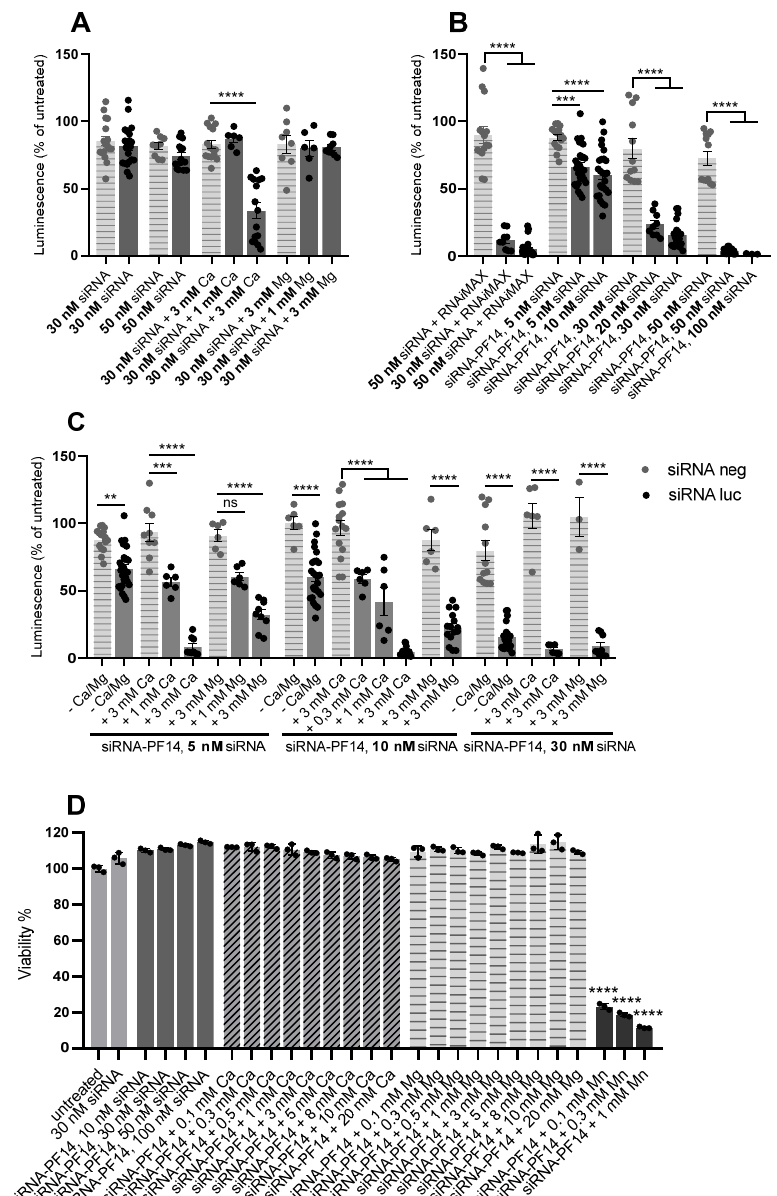
Figure 9. Effect of calcium and magnesium ions on siRNA-induced gene silencing and viability of U87 cells. U87-luc2 cells were incubated with nanoparticles of 5 to 100 nM siRNA, PF14 or Lipofectamine RNAiMAX (positive control) and 0.1 to 20 mM Ca 2+ or Mg 2+ . For siRNA-CPP nanoparticle preparation, molar ratio 17 was used (PF14:siRNA), which corresponds to charge (N:P) ratio of 2. ( A – C ) show suppression of luciferase expression by the nanoparticles. Luciferase activity was measured after 48 h of incubation. As a control, negative siRNA was used. Each dataset represents mean ± SEM of at least 3 independent experiments. Luminescence of untreated cells is taken for 100%. Panel ( D ) shows viability of U87 cells that were incubated with different nanoparticles for 24 h. Viability of the cells was evaluated using WST-1 assay, and absorption of untreated cells was taken for 100%. For all solutions, negative siRNA was used. For all nanoparticles with calcium and magnesium, 30 nM siRNA and 510 nM PF14 were used. Each dataset represents mean ± SD of three technical replicates. Data was analyzed by one-way ANOVA with Tukey’s (in the case of ( A – C )) or Dunnett’s test (in the case of ( D )), and asterisks indicate statistically significant difference between indicated datasets or indicated dataset and untreated cells, respectively, ** p -value < 0.005, *** p -value < 0.0005, **** p -value < 0.0001, ns—not